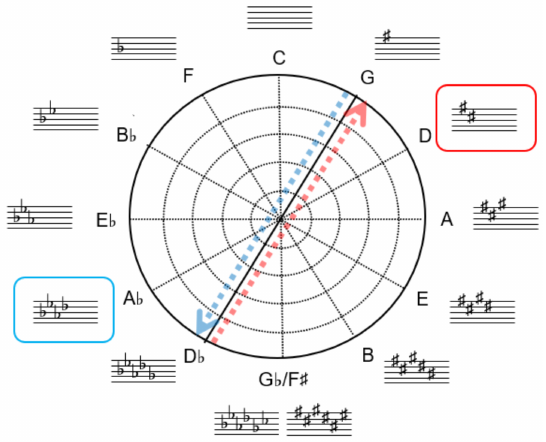
Figure 3. The directed axes D (cid:91) → G and G → D (cid:91) inscribed in the circle of fifths.